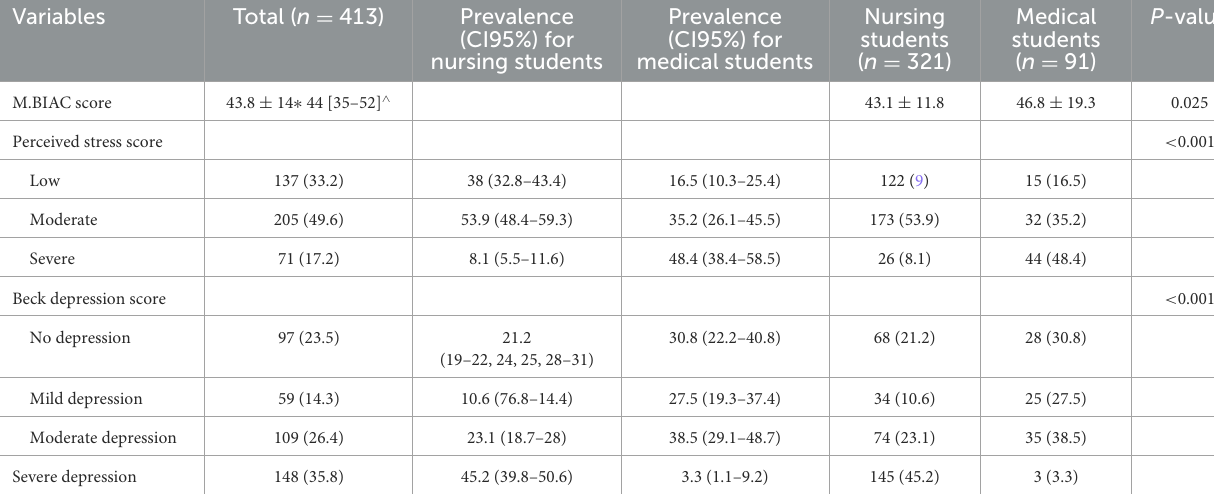
TABLE 2 Levels of depression, stress, and religiosity among the study sample (BIAC).